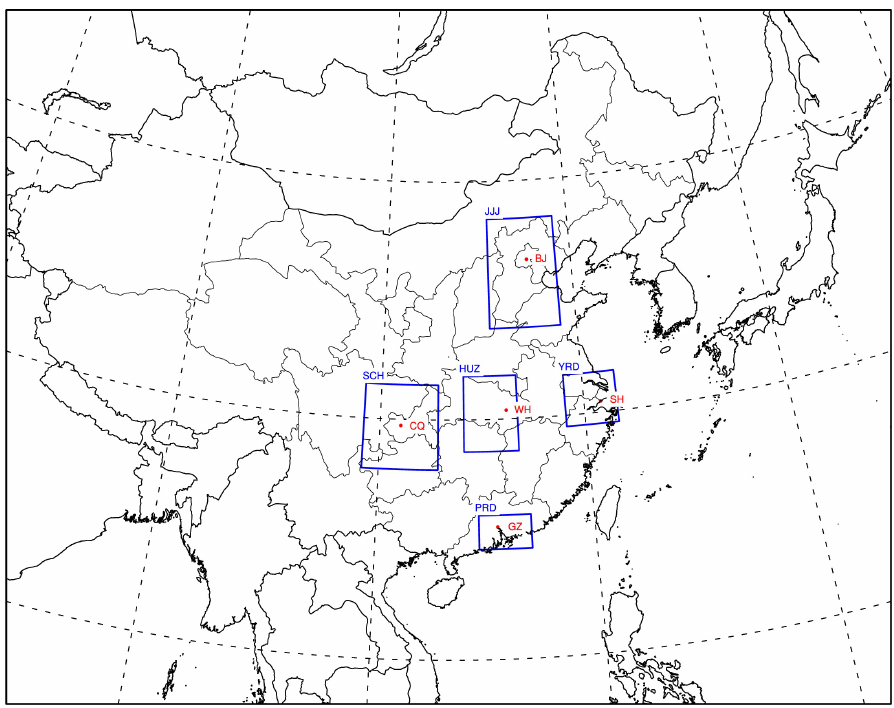
Figure 1. Simulation domain and locations of five selected regions in China. Note: JJJ: Jing-Jin-Ji area; YRD: Yangzi River Delta area; PRD: Pearl River Delta area; SCH: Sichuan Basin area; HUZ: Hubei–Hunan